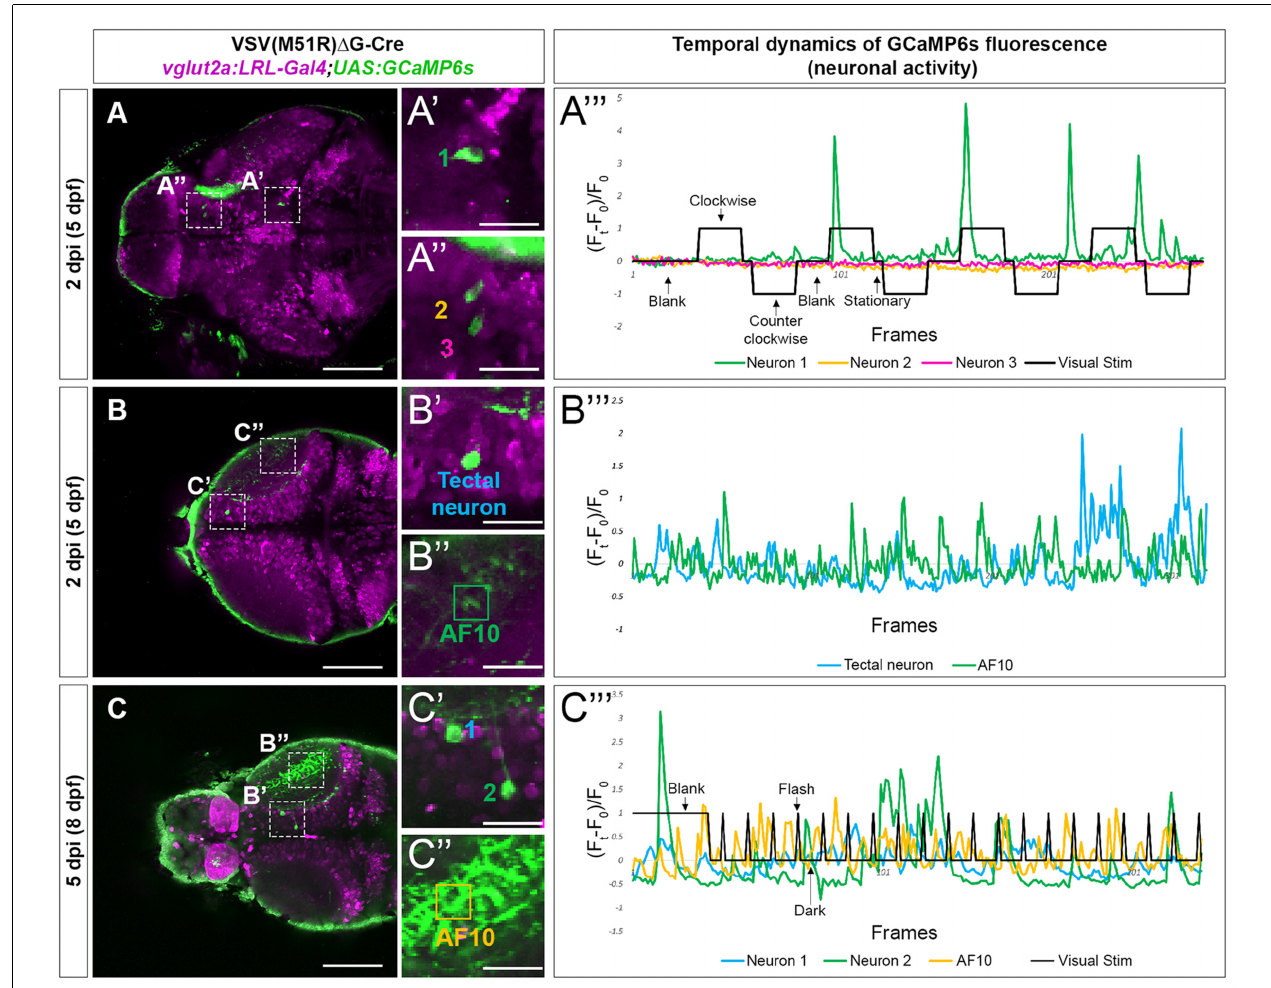
FIGURE 3 | Temporal dynamic of calcium activities in multiple conditions captured from neurons infected with VSV(M51R) ∆ G-Cre in vglut2a:LRL-Gal4;UAS:GCaMP6s fish. All images shown are confocal optical sections. (A–A”’) Neurons ( A’ —neuron in Tegmentum—NucMLF and A” —Dorsal Thalamus neurons) expressing GCaMP6s detected in one XY plain of the brain in a 2 dpi (5 dpf). The evoked transient calcium activity traces (F t − F 0 /F 0 ) during whole field display of moving gratings is shown in (A”’) . (B–B”’) Anterior tectal neuron (B’) and AF10 (B”) , expressing GCaMP6s detected in one XY plain of the brain in a 2 dpi (5 dpf) fish. The spontaneous transient calcium activity traces during uniform illumination (blank) is shown in (C”’) . (C–C”’) Tectal neurons (C’) and AF10 (C”) , expressing GCaMP6s detected in one XY plain of the brain in a 5 dpi (8 dpf) fish. The evoked transient calcium activity traces during whole-field display of 18 s dark/2 s bright flashes is shown in (C”’) . Scale bars in (A–C) are 100 µ m. Scale bars in (A’,A”,B’,B”,C’,C”) are 25 µ